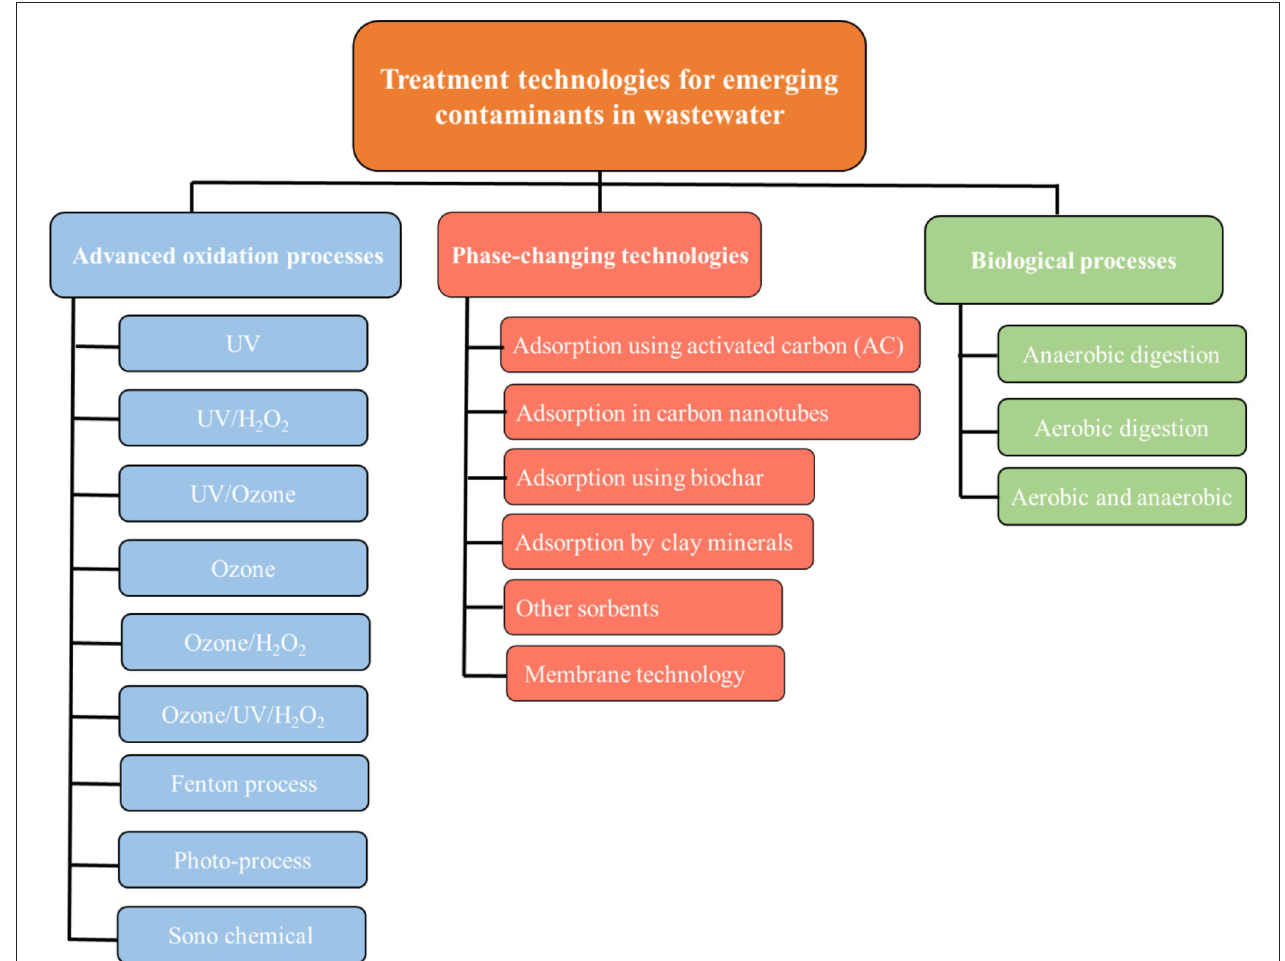
FIGURE 1 | Schematic of wastewater treatment technologies [inspired by Rodriguez-Narvaez et al.